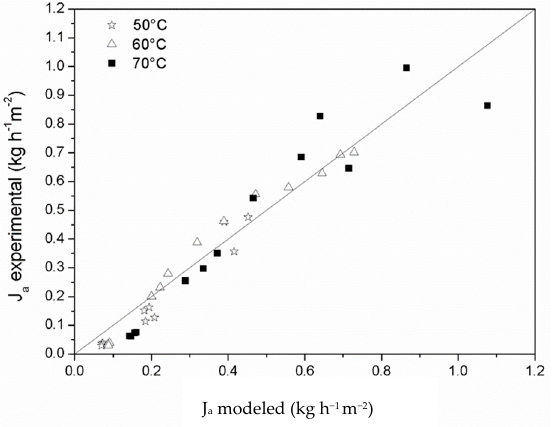
Figure 6. Experimental and modeled values for water permeate flux.